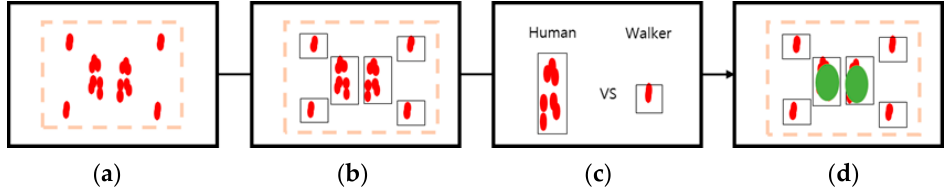
Figure 3. A procedure for foot coordinate measurement of sensing part: ( a ) 2D point cloud collec- tion; ( b ) derivation of candidates through clustering; ( c ) distinction between gait aid devices and foot; ( d ) measurement of foot coordinates.